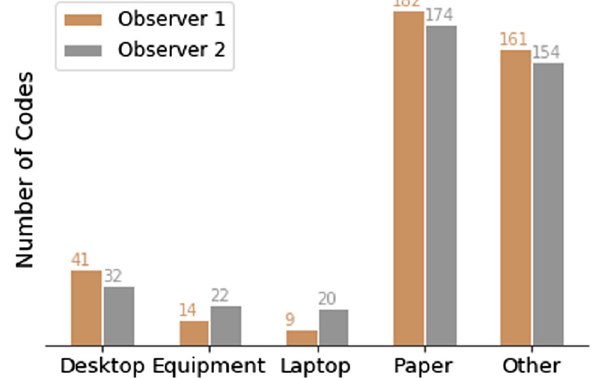
FIG. 1. Bar plot of code counts from two observers used to form the basis of a chi-squared test to validate the observation protocol used in this study. Two observers documented the same lab period, and the resulting contingency table (given by the raw counts displayed on the graph and shown in Table III) was used to determine statistical validity of the method. Here, the two distributions are statistically indistinguishable indicating that the observers captured the same distribution of student actions.